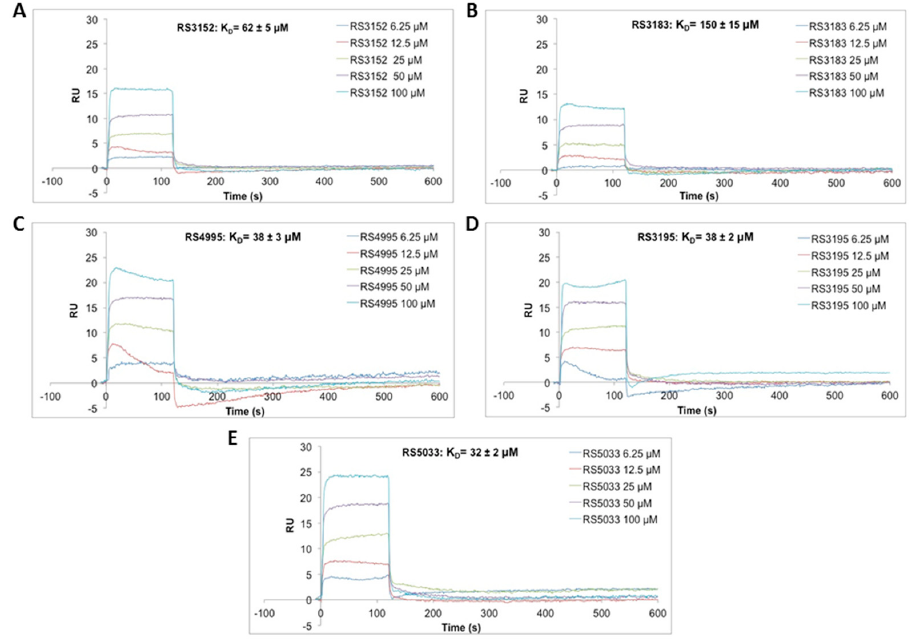
Figure 2. SPR sensorgrams showing the interaction of KDM5D immobilized on a COOH5 sensorchip between inhibitors RS3152 (A), RS3183 (B), RS4995 (C), RS3195 (D), RS5033 (E) in buffer HSP-1%D) at the following concentrations: 6.25 μ M; 12.5 μ M; 25 μ M; 50 μ M; 100 μ M. The increase in RU relative to baseline indicates complex formation; the plateau region represents the steady-state phase of the interaction, whereas the decrease in RU after 120 s represents dissociation of analytes from immobilized KDM5D after injection of buffer HSP-1%D.